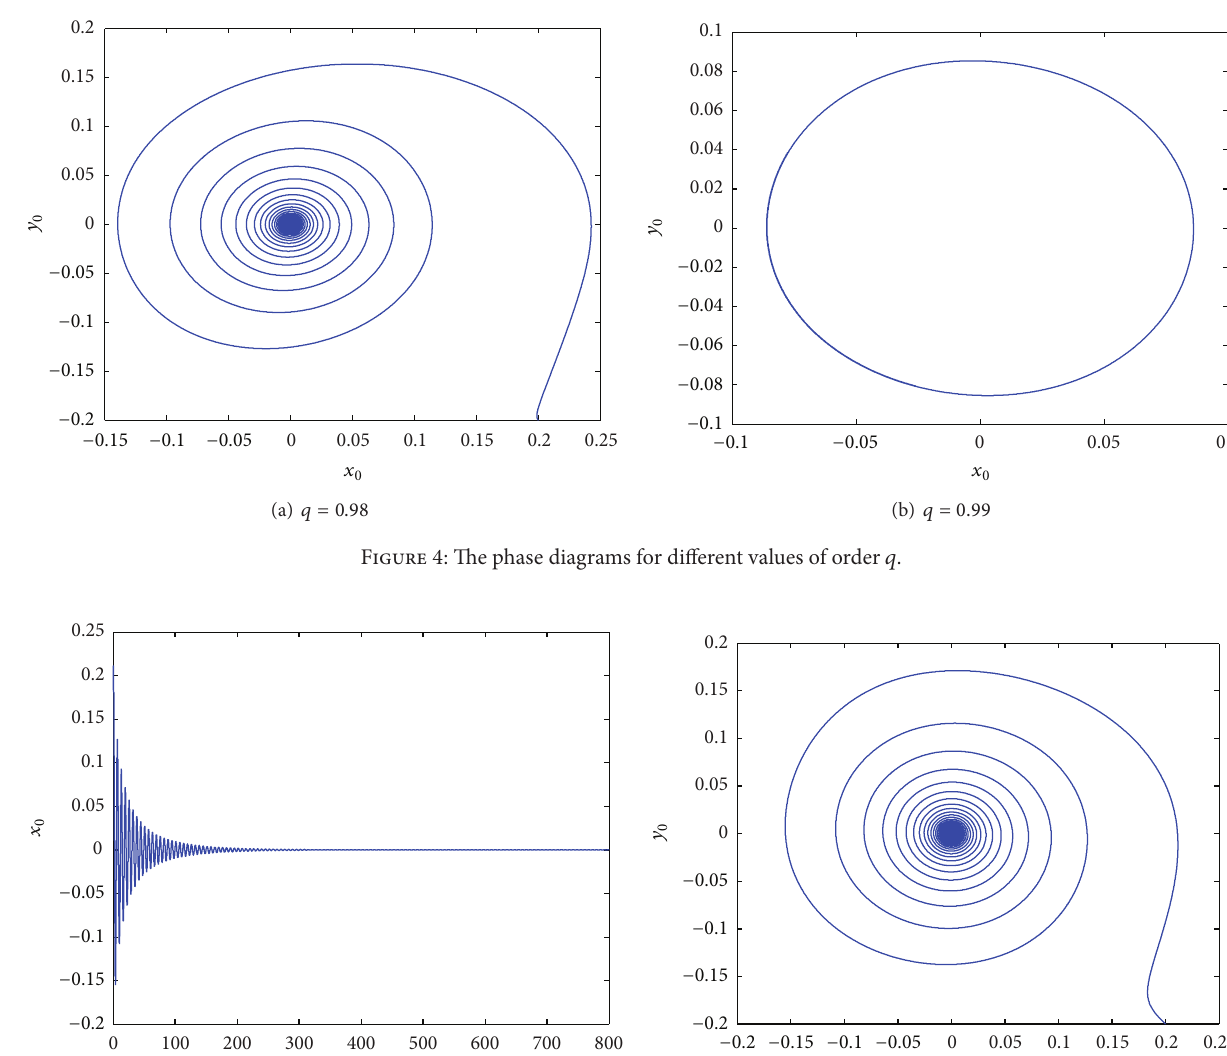
is obtained that the derivative order can also be taken as a bifurcation parameter for fractional-order